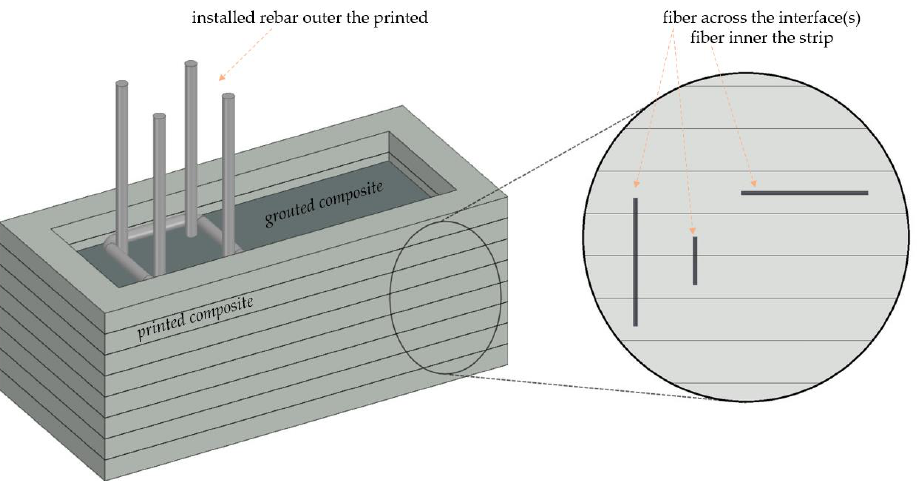
Figure 1. Locations of the reinforcements in the printed structure: inner strips, across the interfaces, and outer printed.